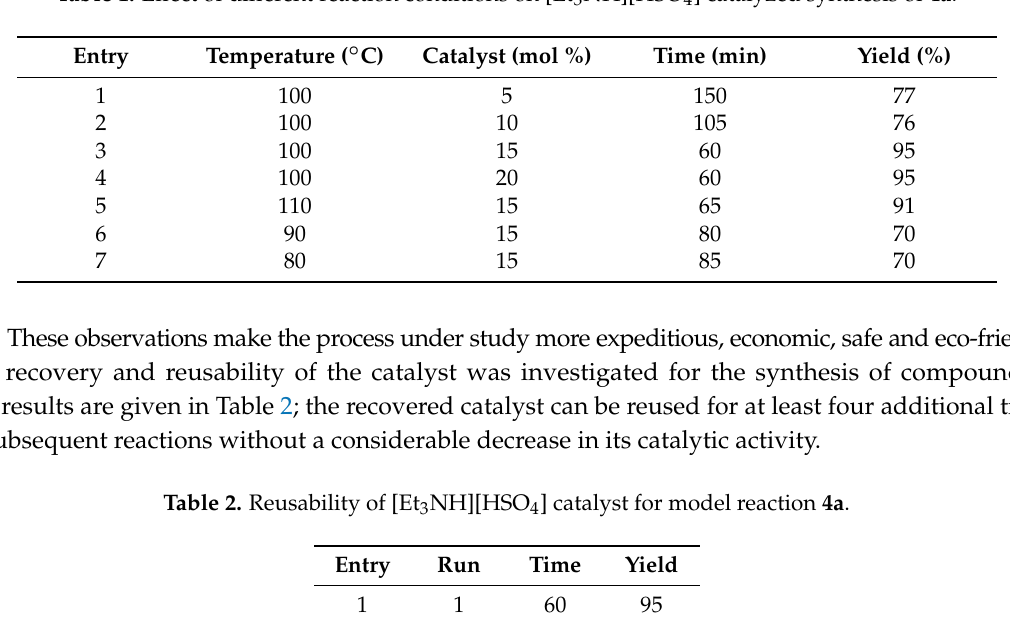
Table 1. Effect of different reaction conditions on [Et 3 NH][HSO 4 ] catalyzed synthesis of 4a .